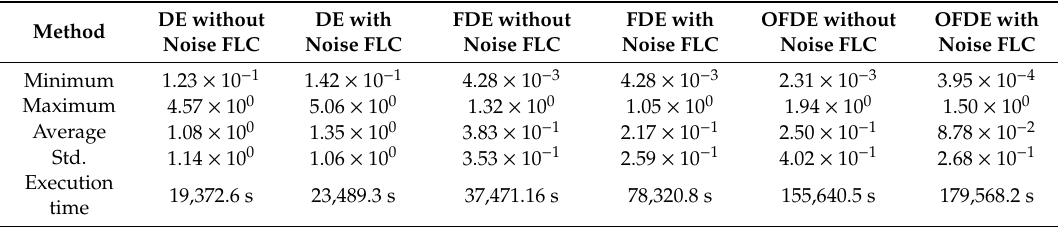
Table 15. Results of the OFDE method applied to robot mobile controller.